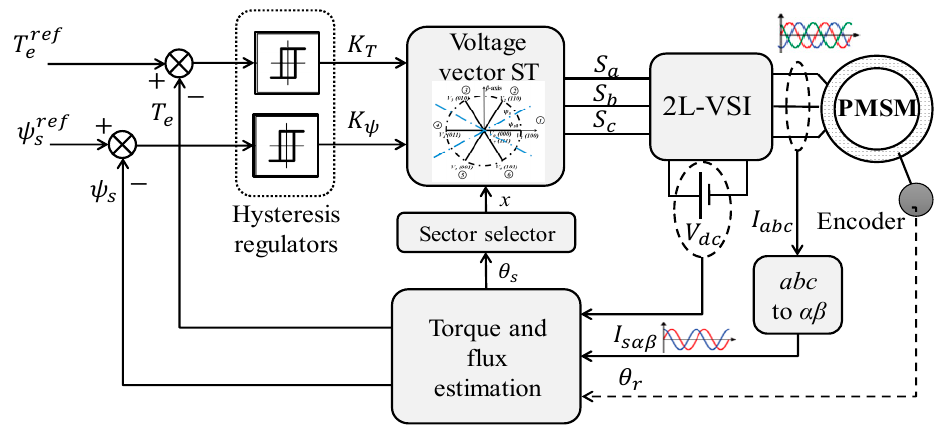
Figure 1. Block diagram of the switching table (ST)-based direct torque control (DTC) technique for permanent magnet synchronous motor (PMSM) .